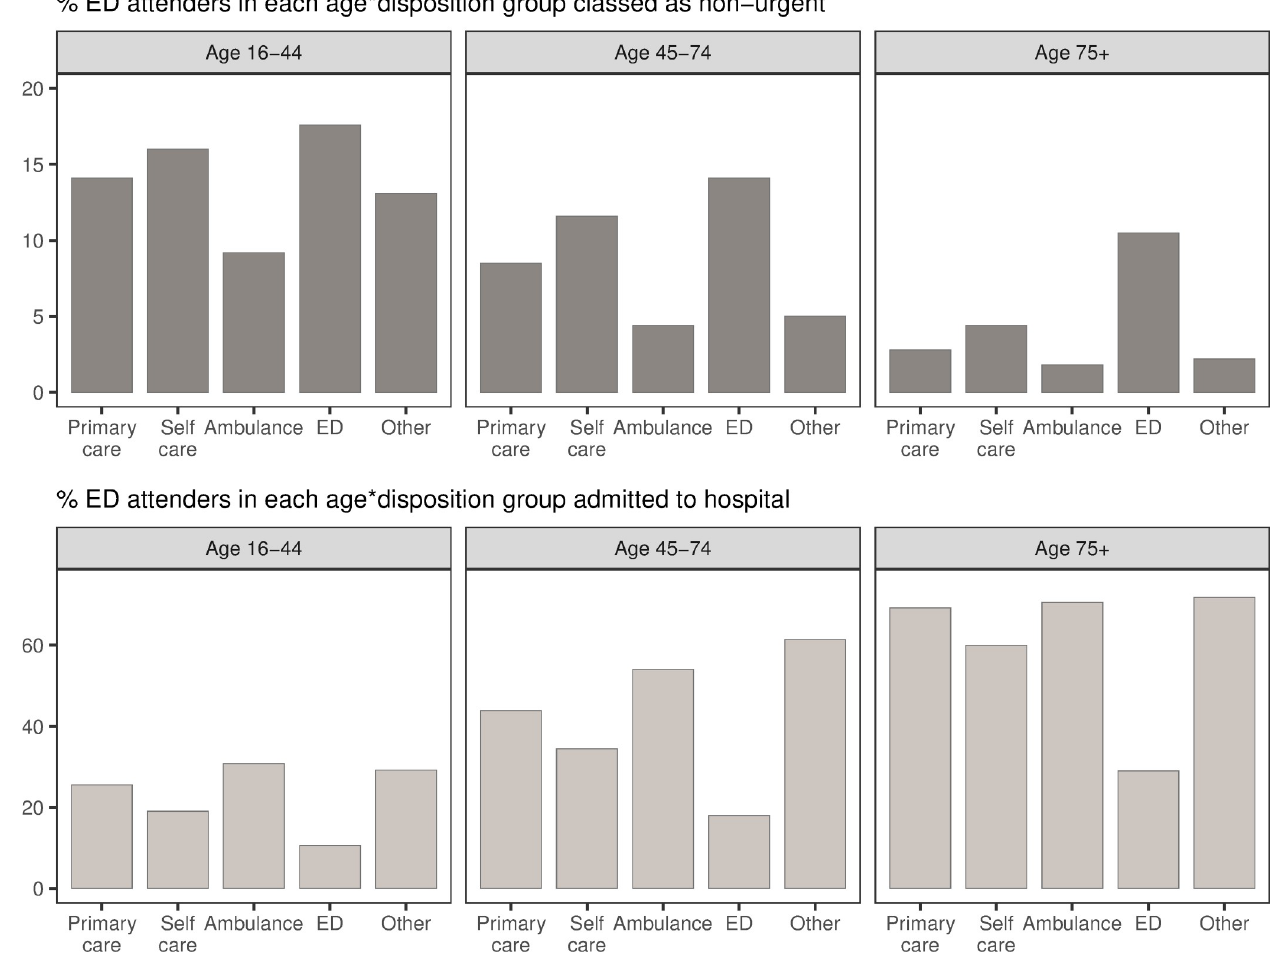
Fig 4. Proportion of ED attendees from each disposition considered non-urgent, and those admitted, by age. Top: percent of NHS 111 callers in each age-disposition group who attended ED, who were classed as non-urgent; e.g., 14.1% of callers aged 16–44, who received a primary care disposition but attended ED, were classed as non-urgent. Bottom: percent of NHS 111 callers in each age-disposition group who attended ED, who were subsequently admitted; e.g., 25.5% of callers aged 16–44, who received a primary care disposition but attended ED, were admitted. Note that relative numbers of patients in these disposition groups are markedly different (see Fig